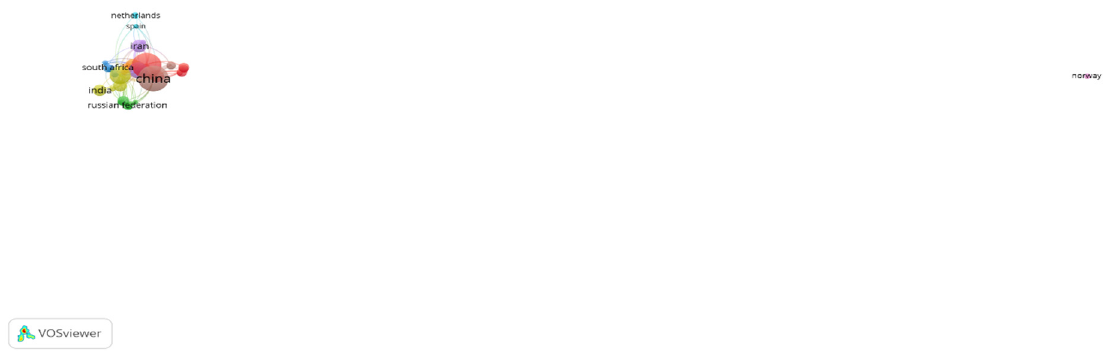
Figure 3. VOSViewer mapping of active countries in risk management in construction.